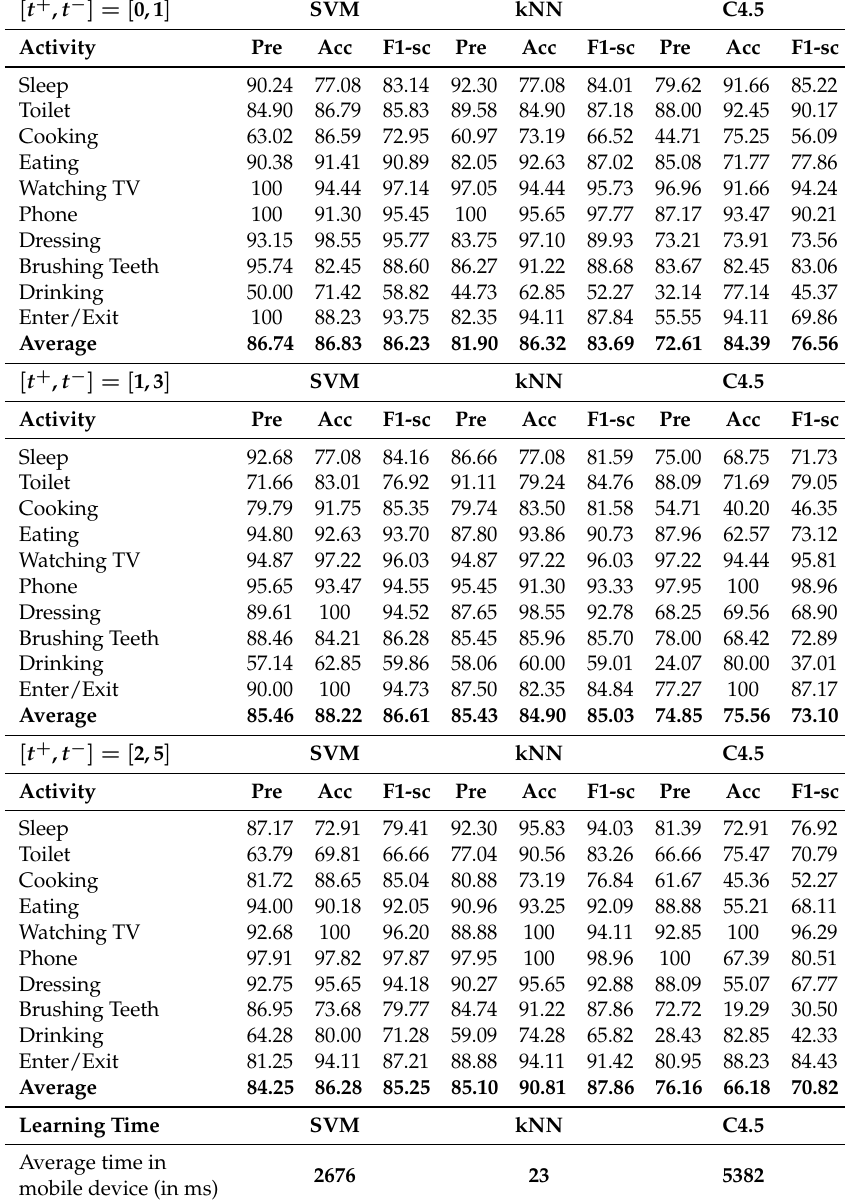
Table 4. Results with fuzzy features (spatial): precision (Pre), recall (Rec) and F1-score